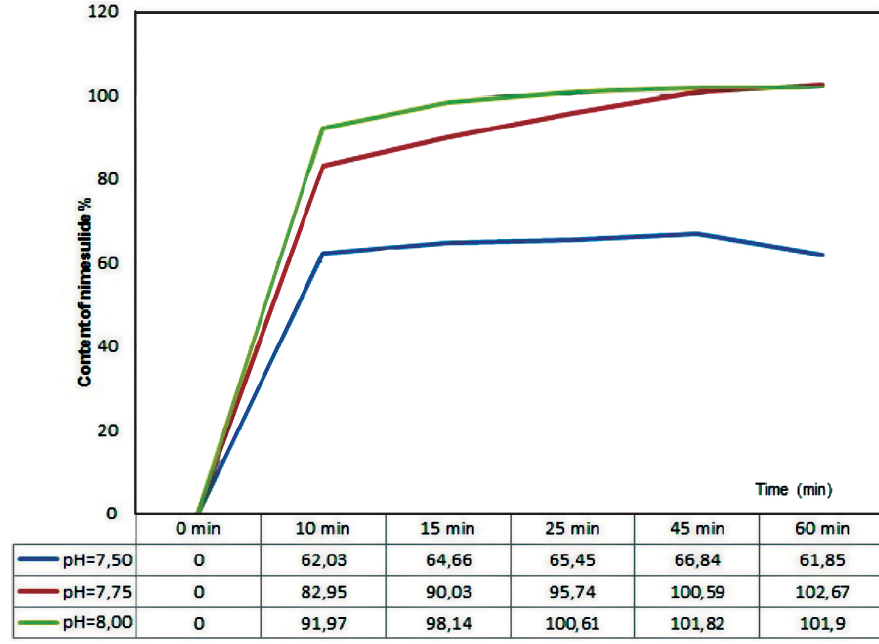
Figure 4. Dependence of nimesulide dissolution profiles from pharmaceutical preparation A on the pH 7.5 of the dissolution